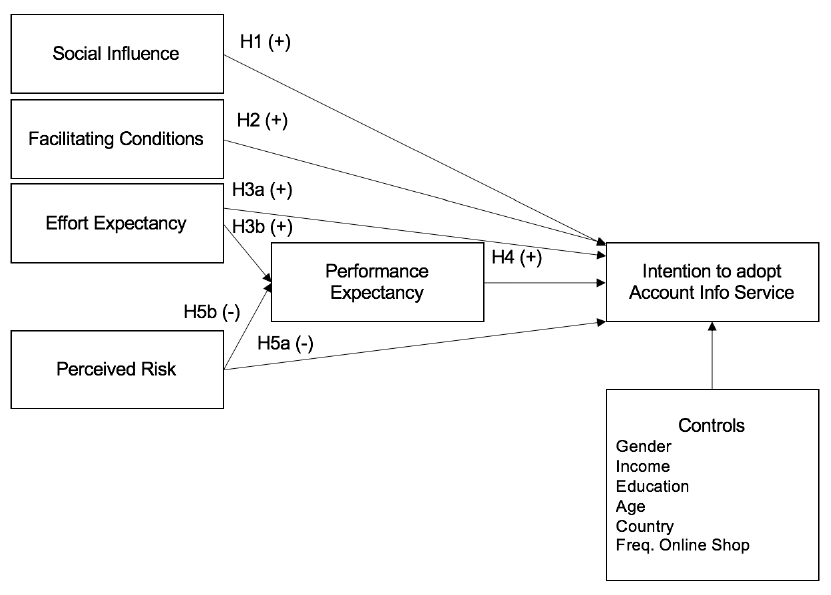
Figure 1. Research